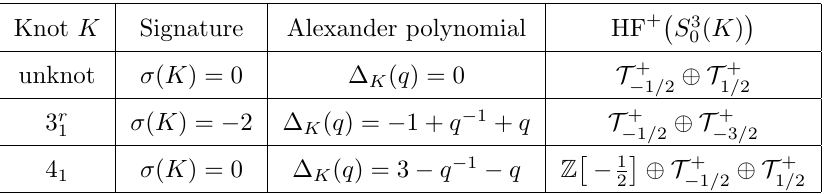
( K ) ; s h ) (cid:24) = 0 unless h = 0. 0